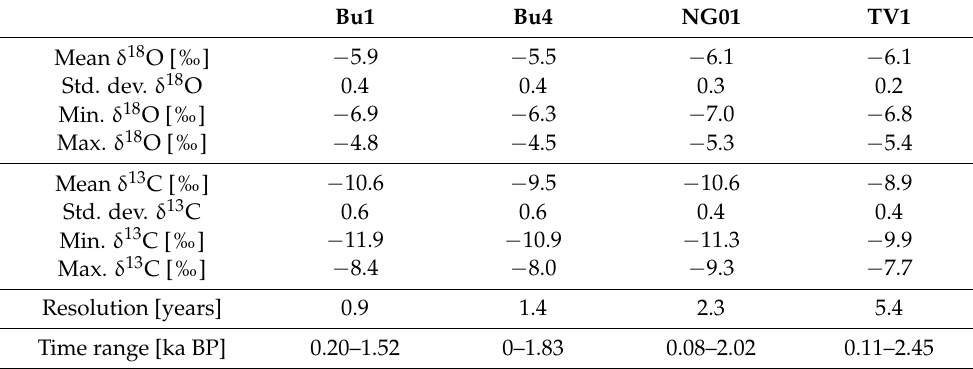
Table 2. Mean δ 18 O and δ 13 C values, standard deviations, minima and maxima as well as the temporal resolution and the time range of the stable isotope records of Bu1 and Bu4 from Bunker Cave as well as NG01 and TV1 from the Herbstlabyrinth.